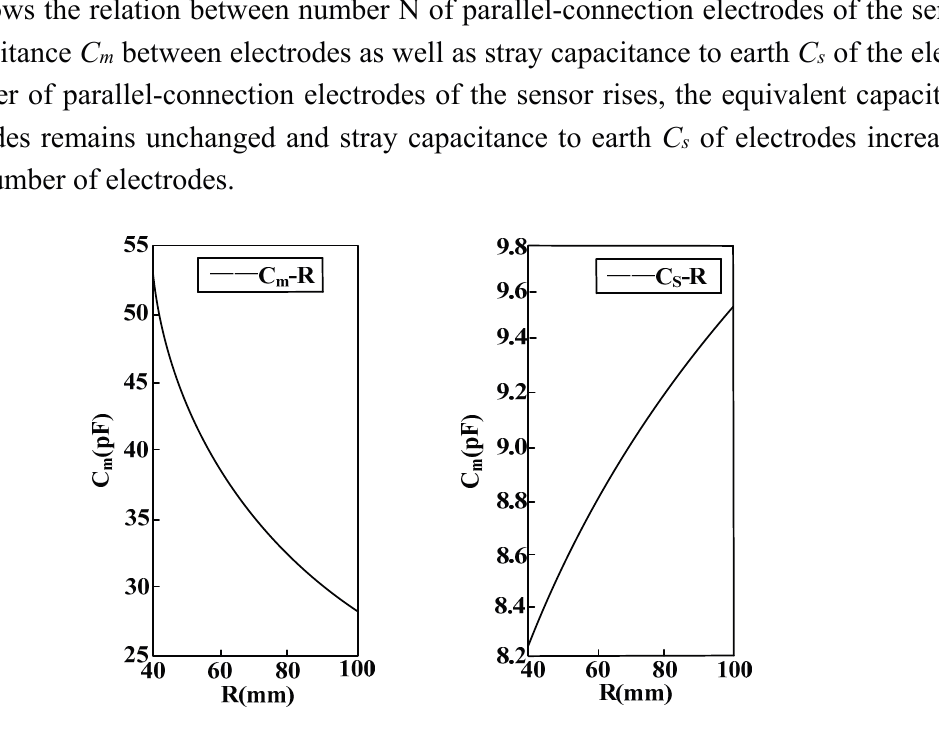
Figure 12. Curve of the relation between equivalent capacitance parameters and electrode radius.